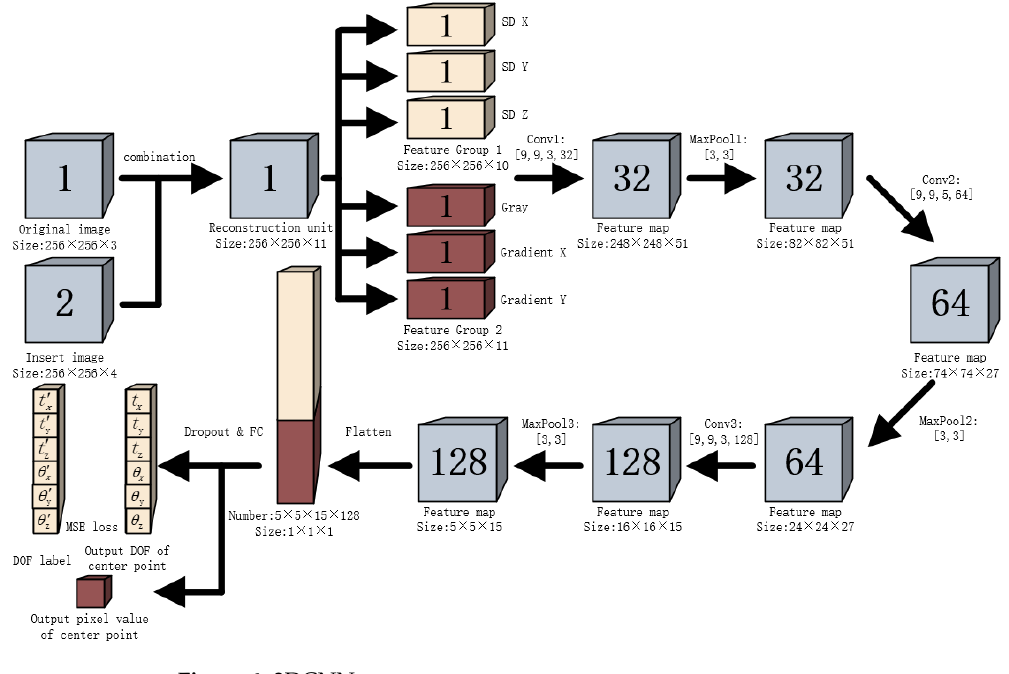
Figure 6. 3DCNN structure.